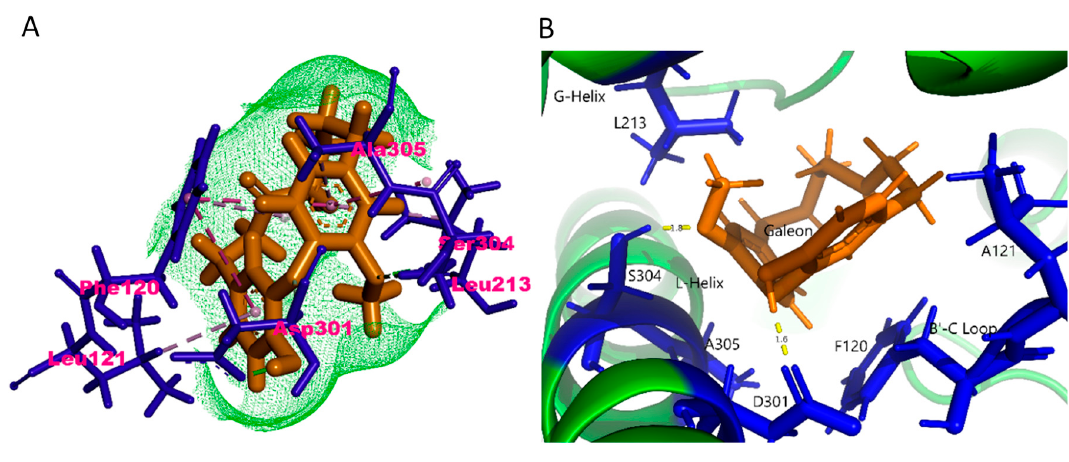
Figure 8. ( A ) 2D interaction mechanism of CYP2D6–galeon; ( B ) 3D interaction mechanism of CYP2D6–galeon.